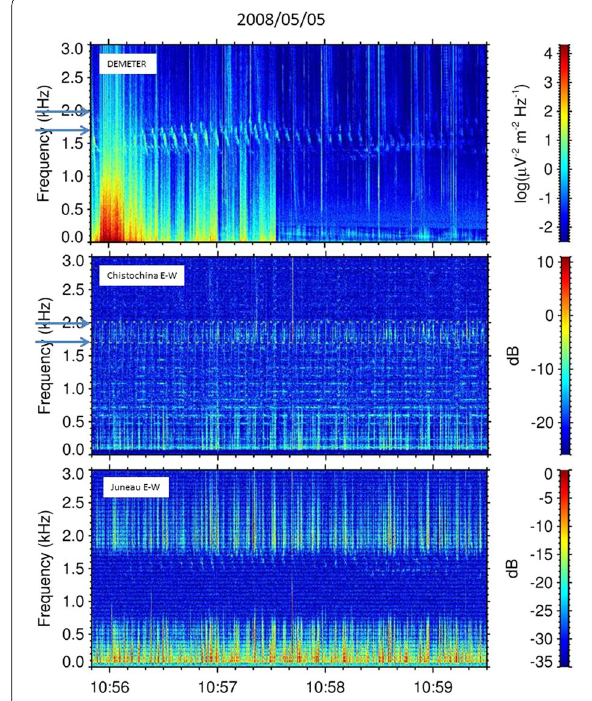
Fig. 8 Orbit of DEMETER on 5 May, 2008 with times showing the positions of HAARP and its magnetically conjugate point